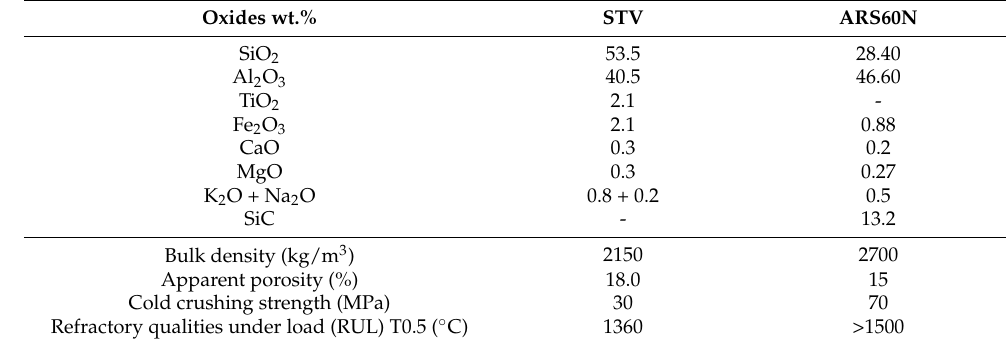
Table 3. Chemical composition and properties of refractory materials. Oxides